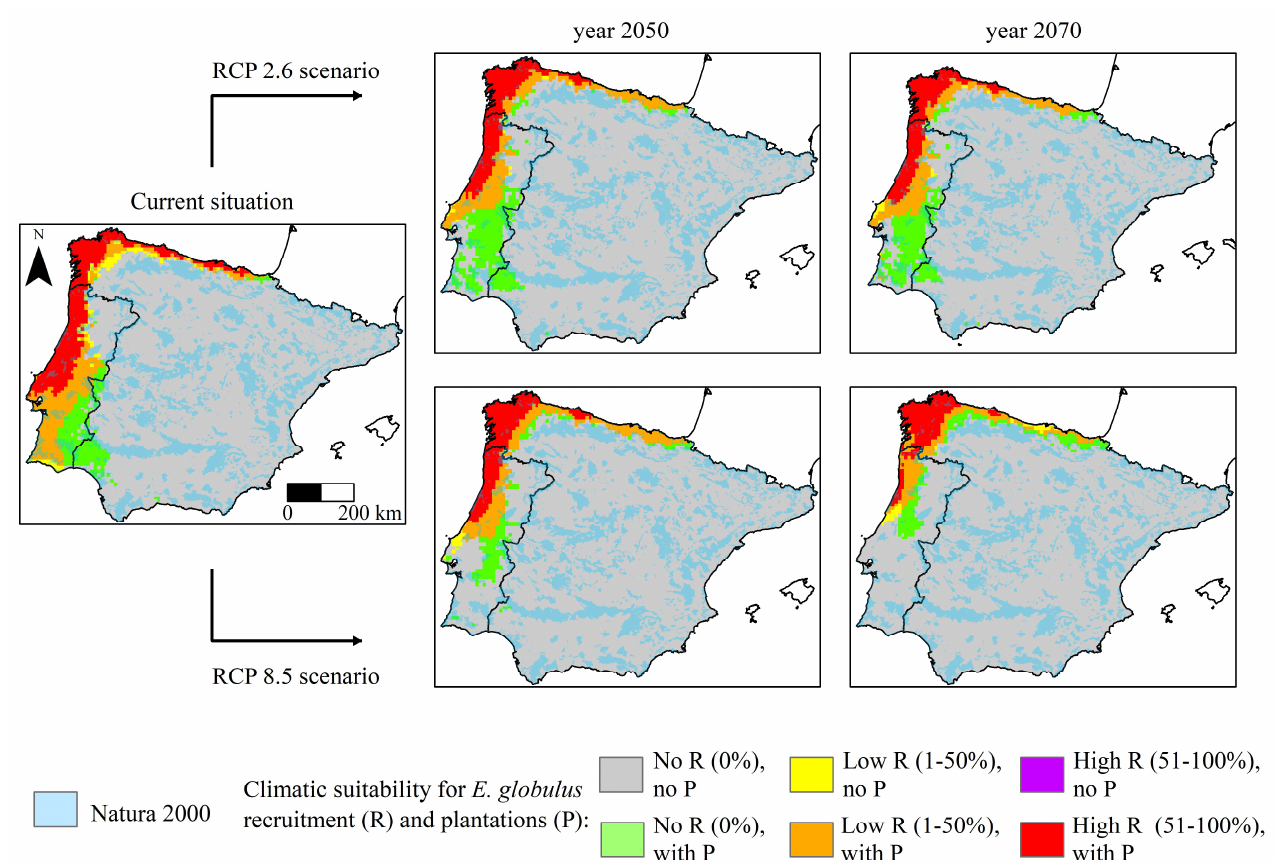
Figure 3. Current and future climatic suitability (%) for Eucalyptus globulus plantations and E. globulus recruitment in the years 2050 and 2070 under climate change scenarios RCP2.6 and RCP8.5. Climatic suitability corresponds to the probability (%) of finding